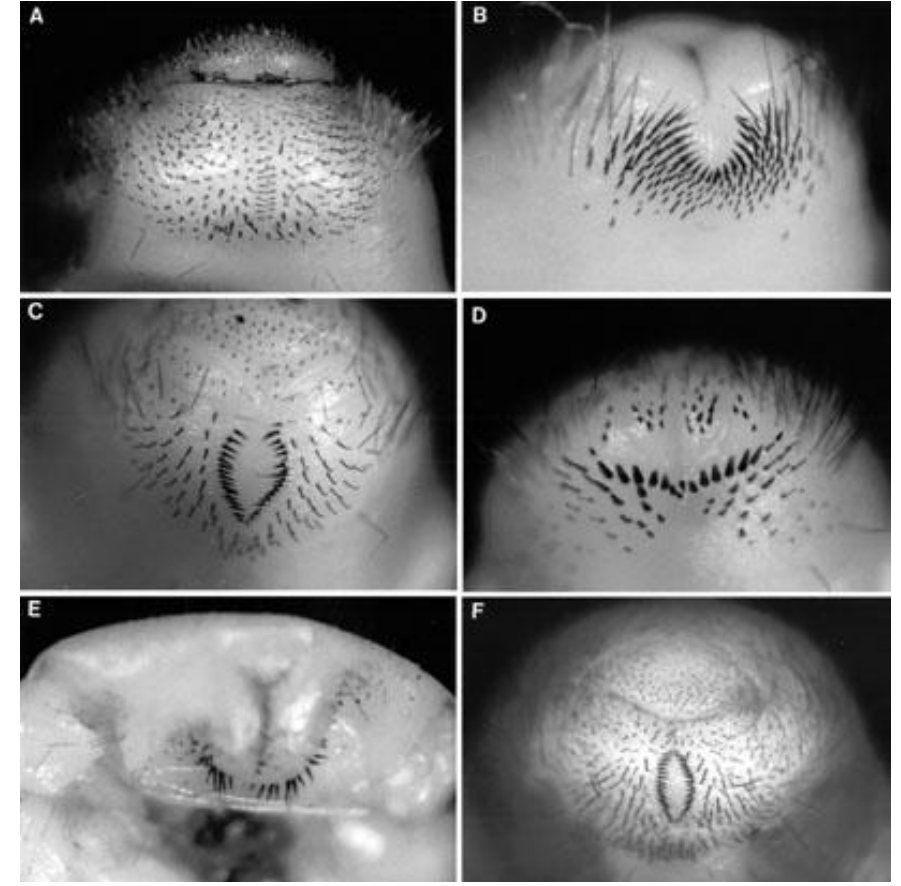
Figure 4. Rasters of white grubs found at JSP. A, Cochliotis melolonthoides ; B, ? Triodontella sp. A; C, ? Schizonycha sp.; D, unknown Melolonthinae sp.; E, unknown Cetoniinae; F, Brachylepis werneri (the letters correspond to the code letters used). Photographs by A.